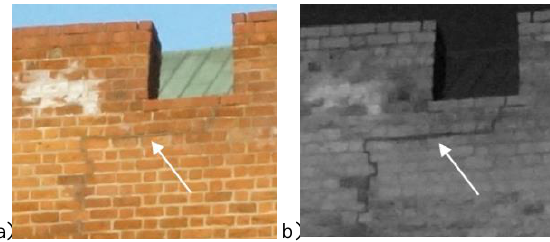
Figure 12. Repaired cracks in the wall of an old church in the